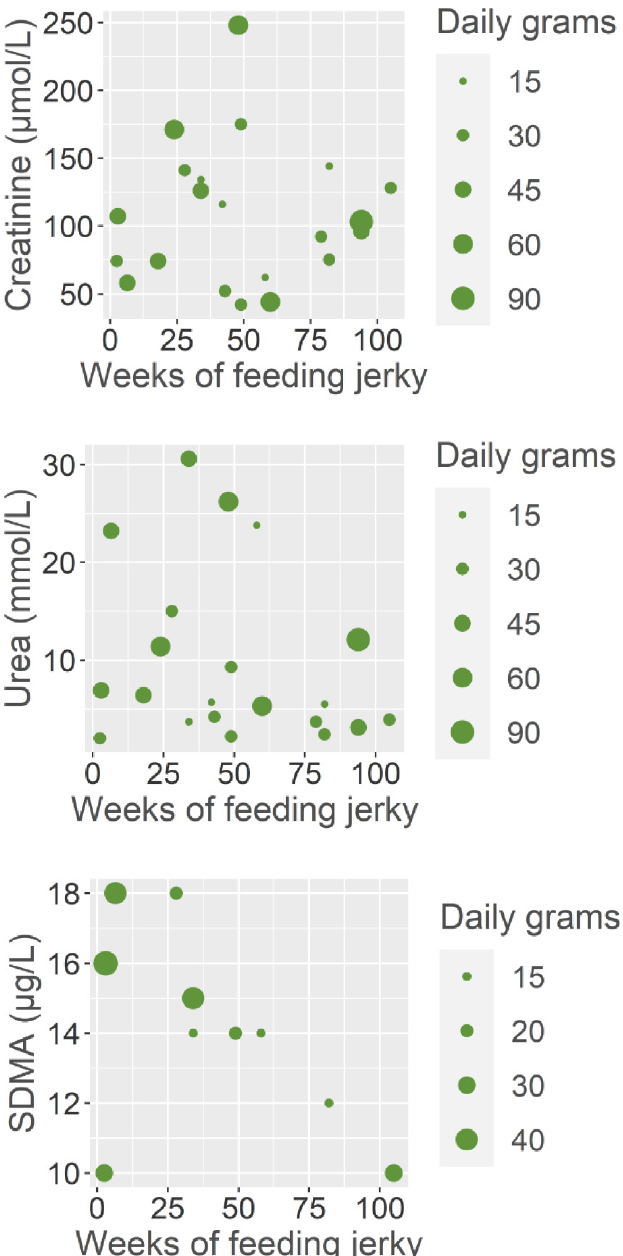
Figure 4. Bubble chart between markers of glomerular function, estimated duration and amount of jerky ingestion in dogs diagnosed with jerky induced Fanconi syndrome. On the y -axis the concen- tration of the glomerular function marker (serum creatinine ( µ mol/L), symmetric dimethylarginine (SDMA) ( µ g/L), and urea (mmol/L)), and on the x -axis the estimated duration of jerky ingestion (weeks). The size of the dots differ depending on the estimated amount of daily jerky fed to each dog. Creatinine and urea data was available from 21 dogs, while only 10 dogs had SDMA concentration measured at the time of